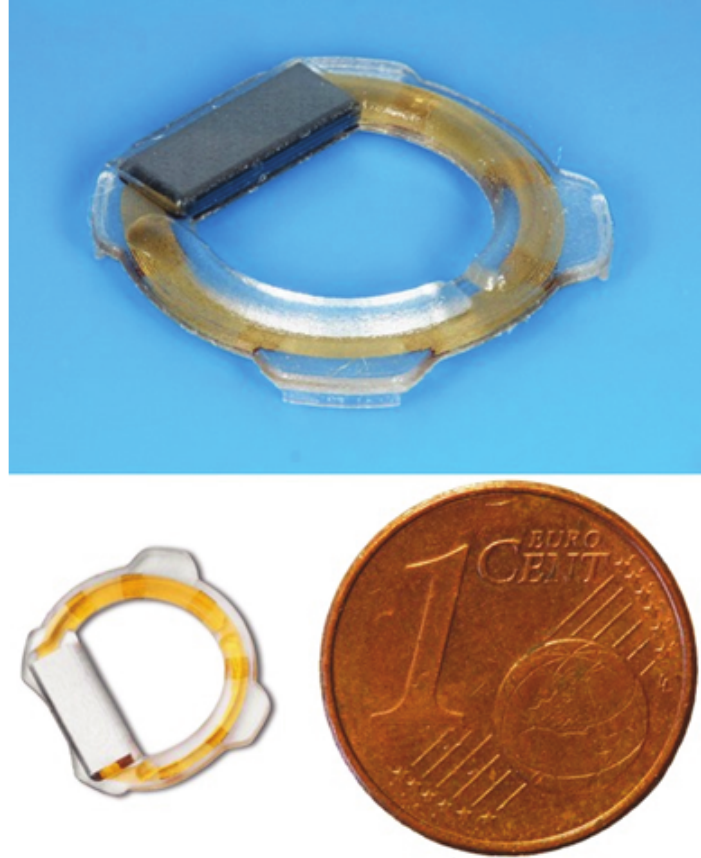
Figure 2. Eyemate intraocular sensor (top) and a size comparison with a eurocent